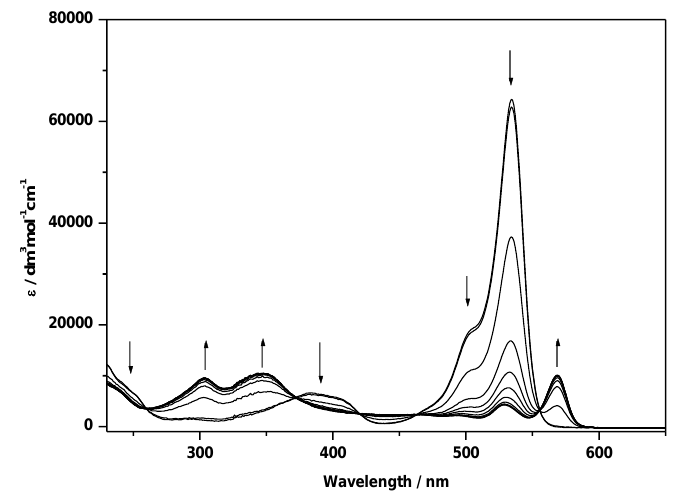
Figure 5. UV-vis spectroelectrochemsitry of 2 in CH 2 Cl 2 with [ n Bu 4 N][BF 4 ] as electrolyte at 243 K. Arrows indicate progress of reduction.